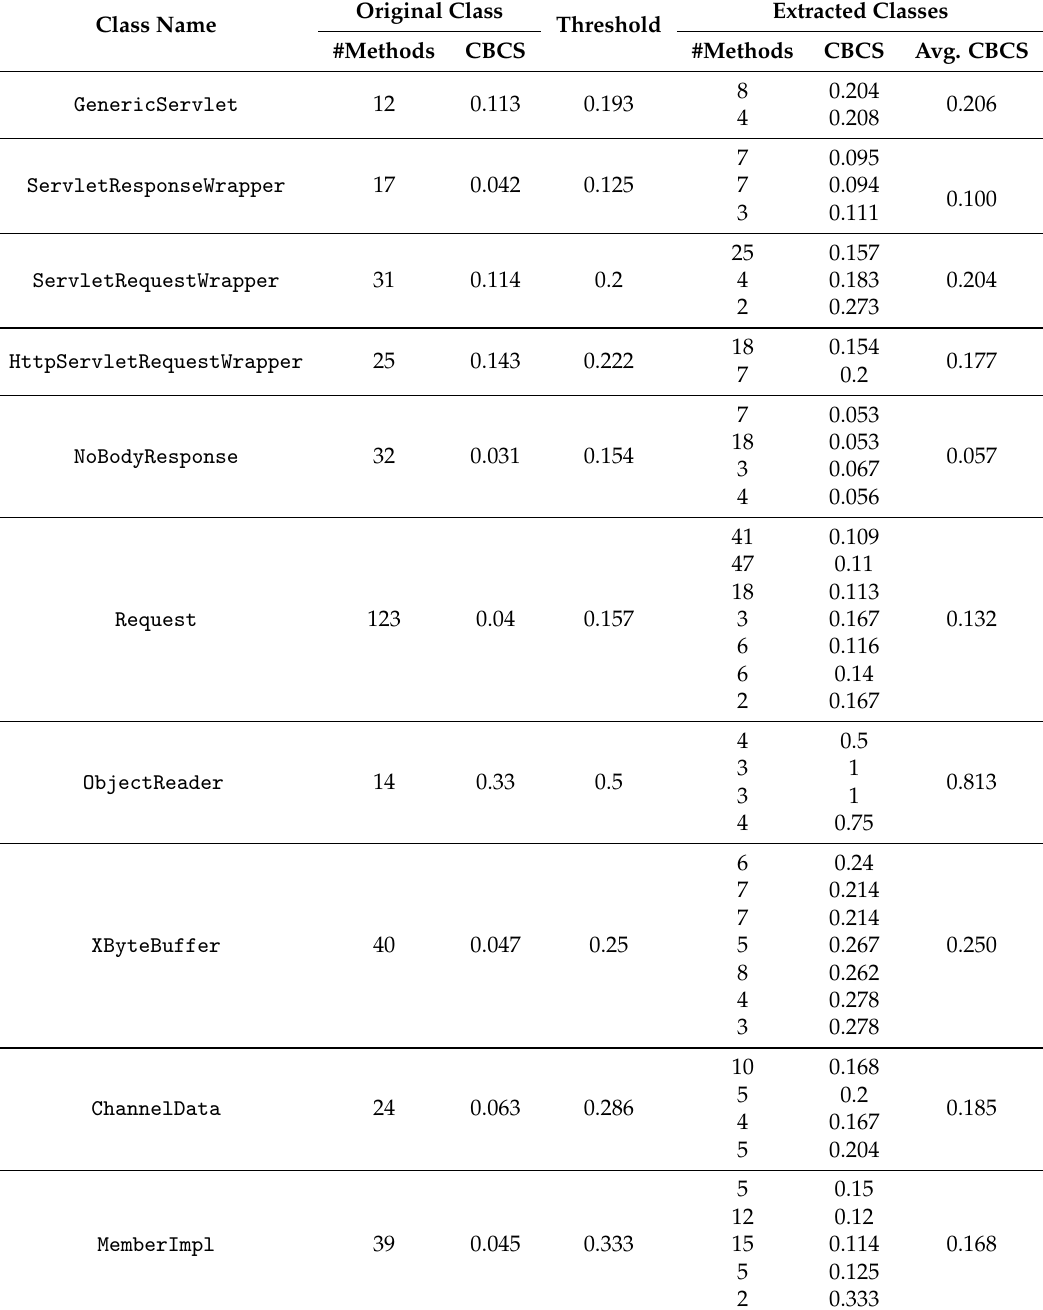
Table 4. Extracted classes suggested by our approach for the considered classes of the Tomcat